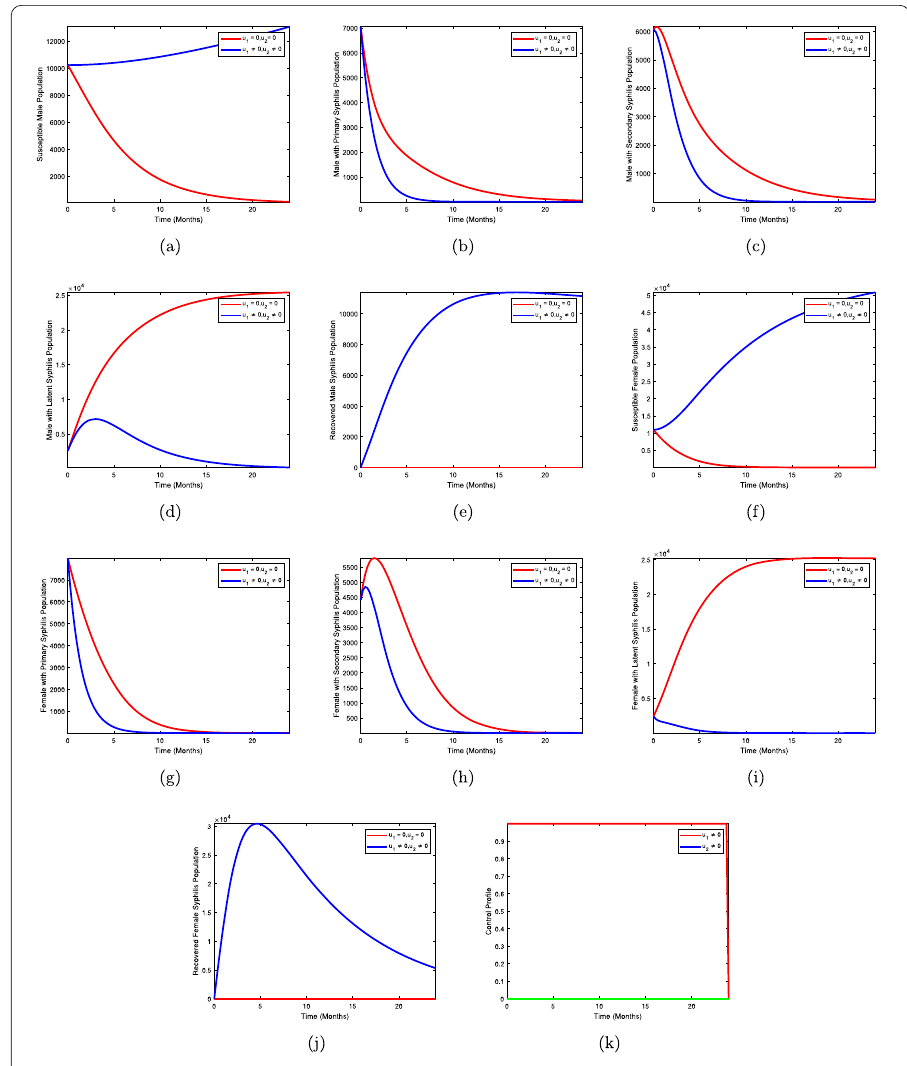
Figure 2 Use of condom + treatment of male with syphilis infection